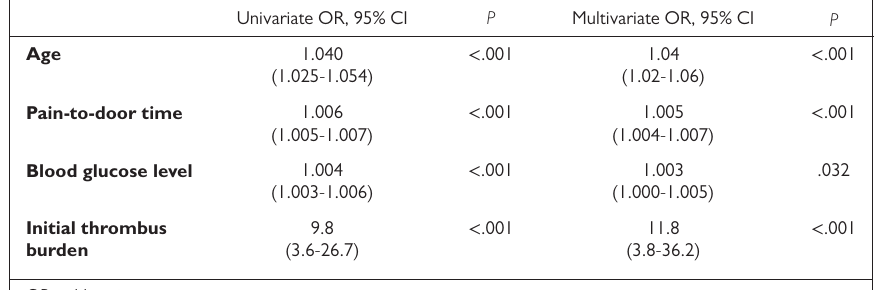
Table 4. Results of a Multivariate Logistic Regression Analysis Performed to Estimate Post-Processing No-Reflow